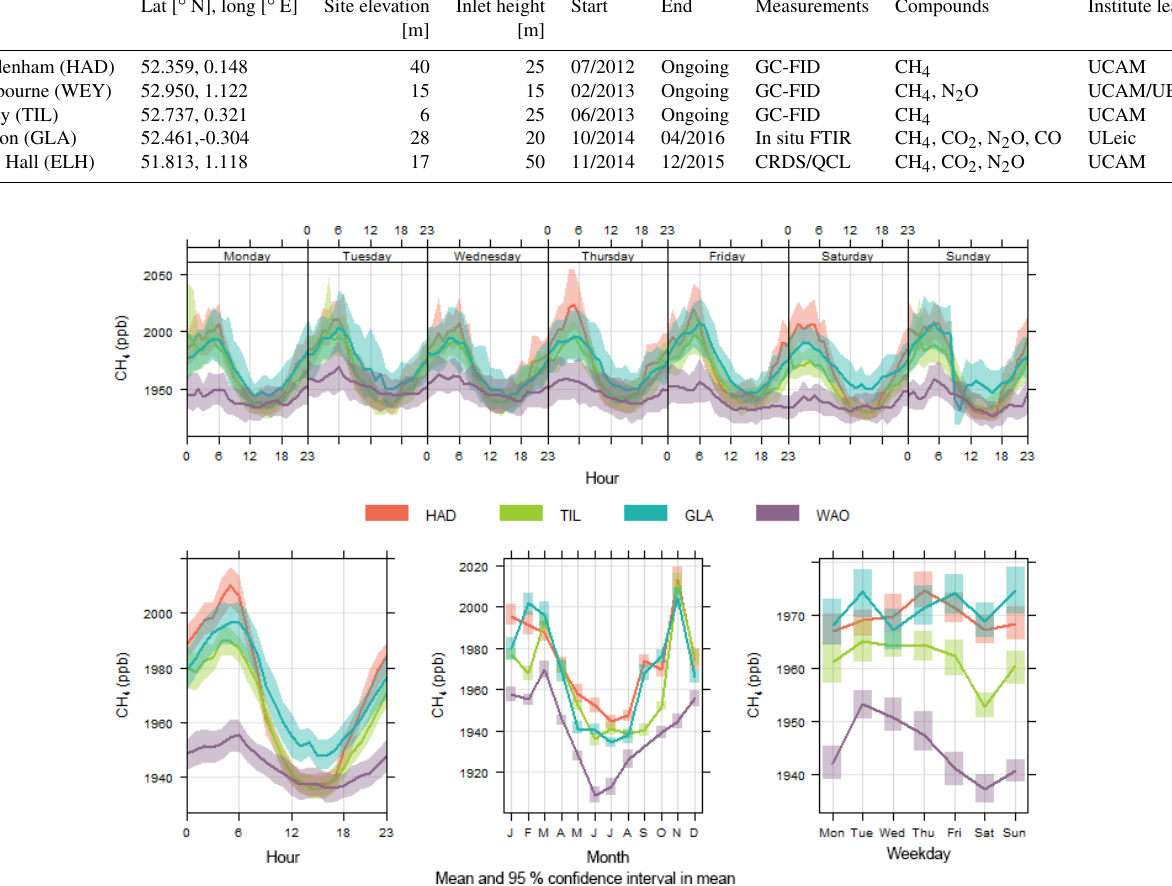
Figure 3. Observed variations of CH 4 mole fraction data collected at one atmospheric observatory (Weybourne, WAO, 13 February 2013–6 May 2014) and three church steeples at Haddenham (HAD, 3 July 2012–23 September 2015), Tilney (TIL, 7 June 2013–31 August